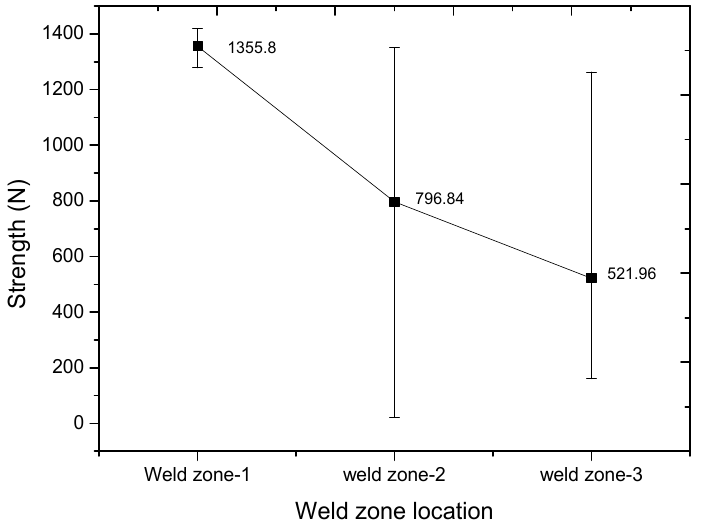
Figure 11. Six kinds of displacement–strength curves represented by multi-layer ultrasonic welding in a multi-step shear strength test.